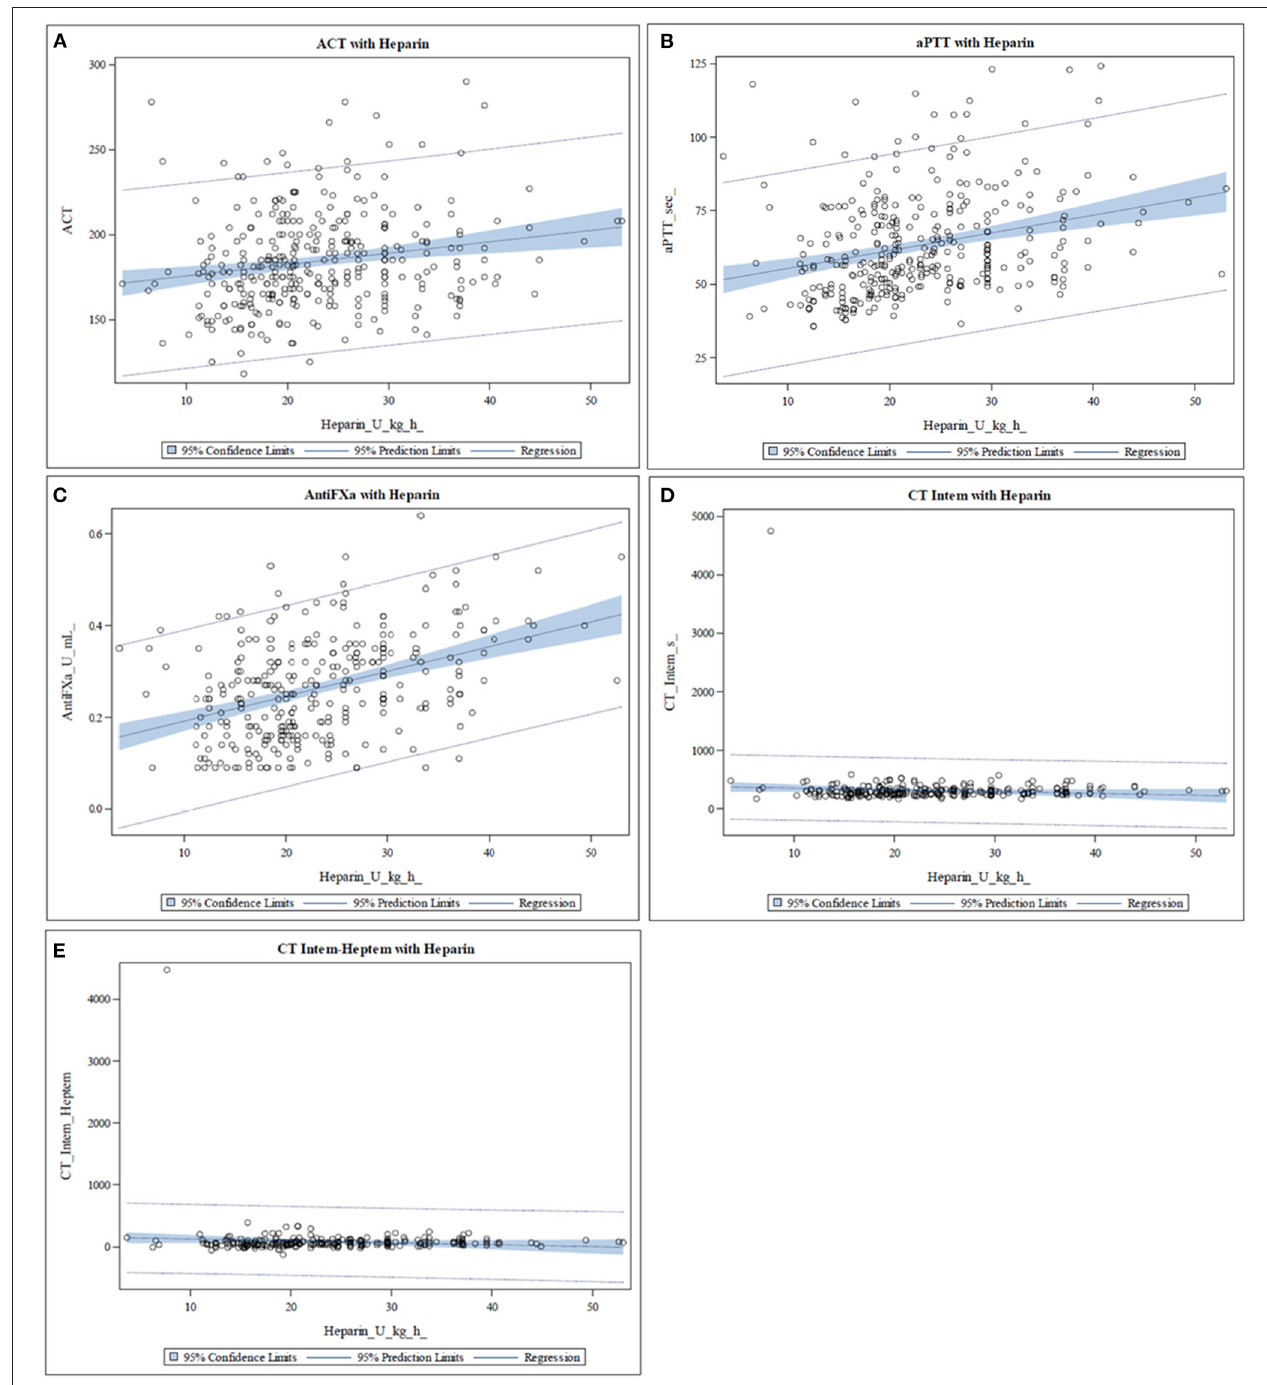
FIGURE 1 | Scatter plots representing the relationship between heparin dose and the different coagulation assays. The blue area represents the 95% confidence limit of the mean predicted values of the regression line. ( A–C ) The values of activated clotting time (ACT), activated partial thromboplastin time (aPTT), and anti-Xa assay increase with increasing heparin dose. In the case of anti-Xa assay, fewer outlying values and a steeper regression line are seen. ( D,E ) The slightly slanted horizontal line indicates a lack of sensitivity of the clotting time in INTEM (CT-INTEM) and INTEM-HEPTEM (CT-Diff) in response to a change in heparin dose.